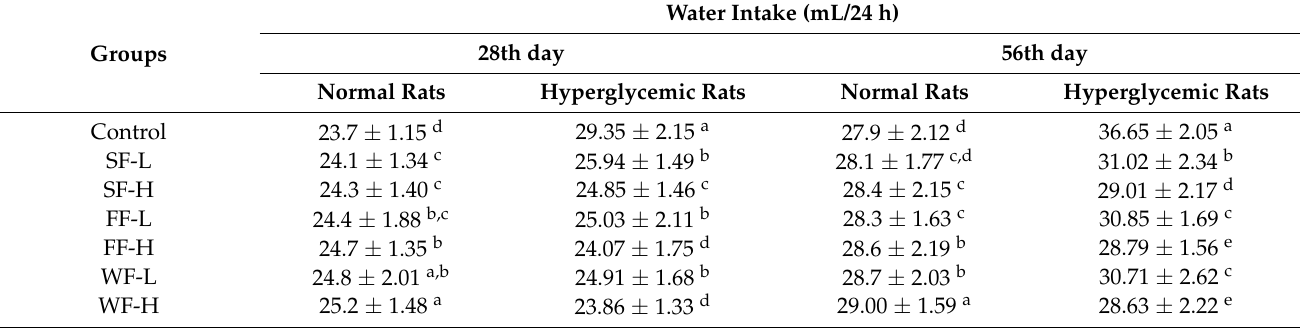
Table 1. Impact of bitter melon supplementation on water intake of